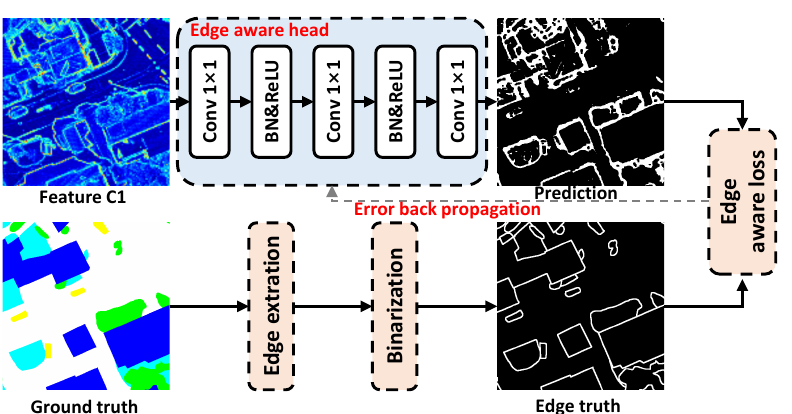
Figure 10. Illustration of the implicit edge enhancement